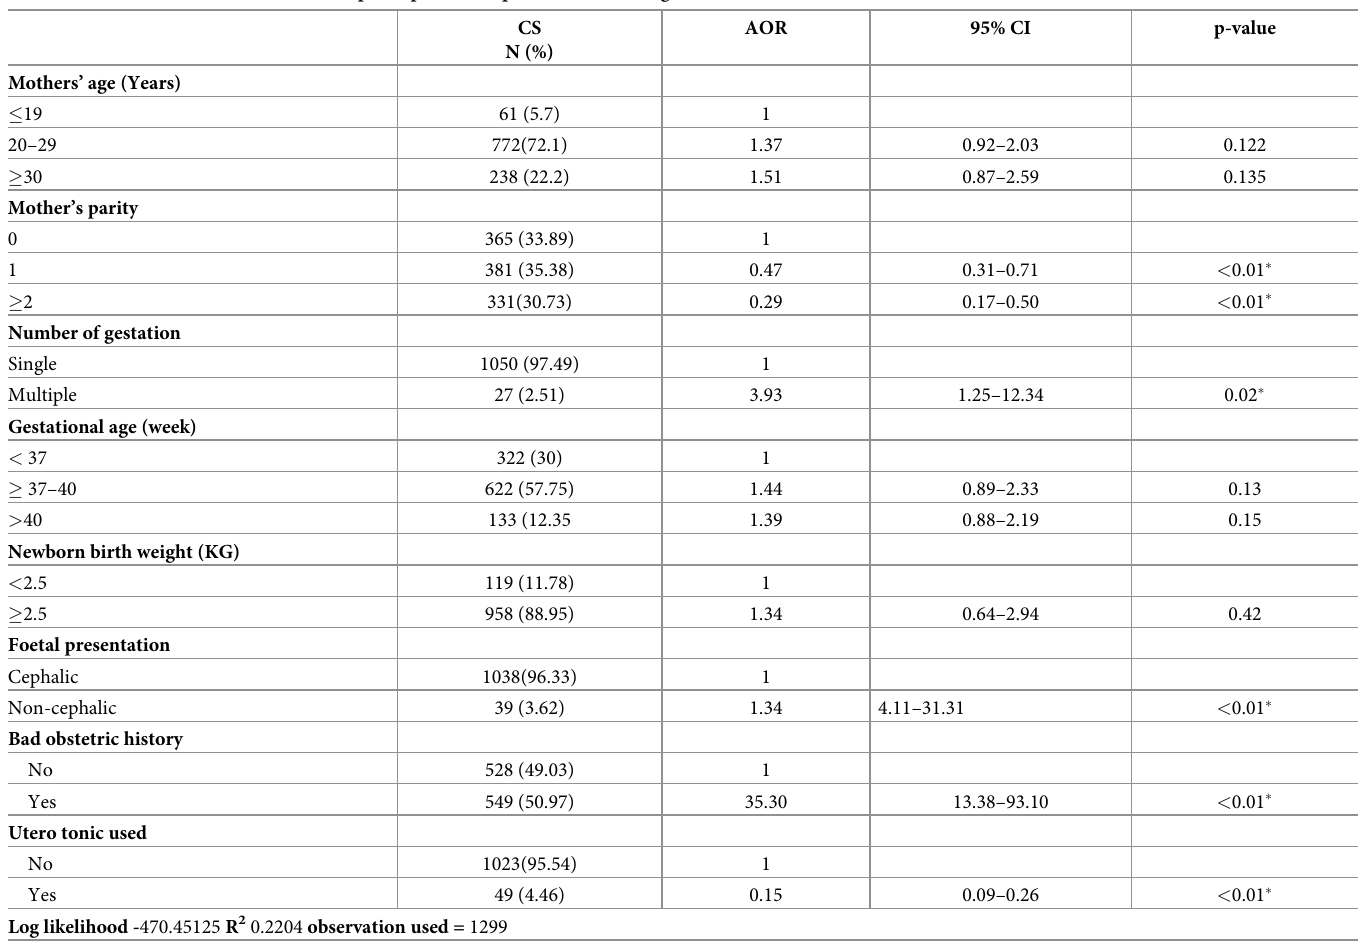
Table 3. Determinants of CS births in for-profit private hospitals in urban